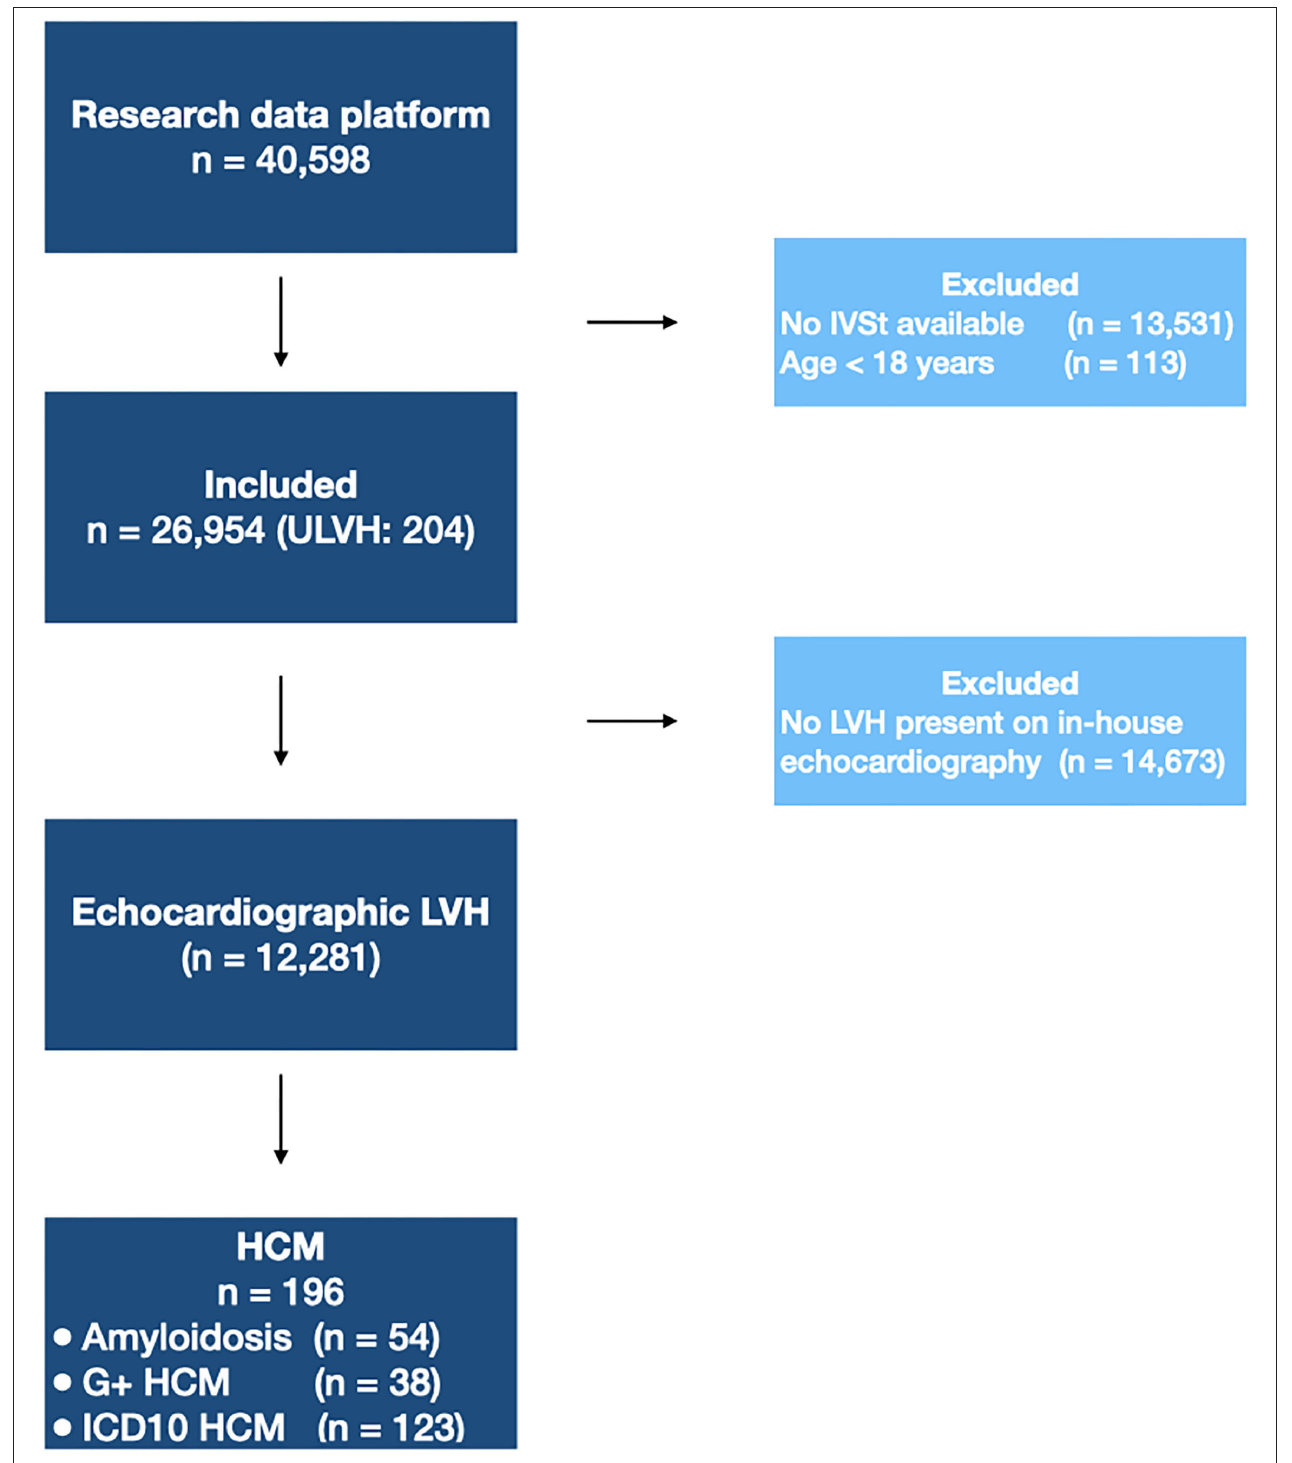
FIGURE 1 | Flow diagram of patient inclusion. Flow diagram showing the patients excluded in each step. For the text-mining algorithm, 26,954 patients were included. The machine learning algorithm was trained on patients with echocardiographic LVH. IVSt, interventricular septum thickness; LVH, left ventricular hypertrophy; ULVH, Unexplained Left Ventricular Hypertrophy; HCM, Hypertrophic Cardiomyopathy; G + , genetically-confirmed; ICD10, World Health Organization International Statistical Classification of Diseases and Related Health Problems, tenth revision.